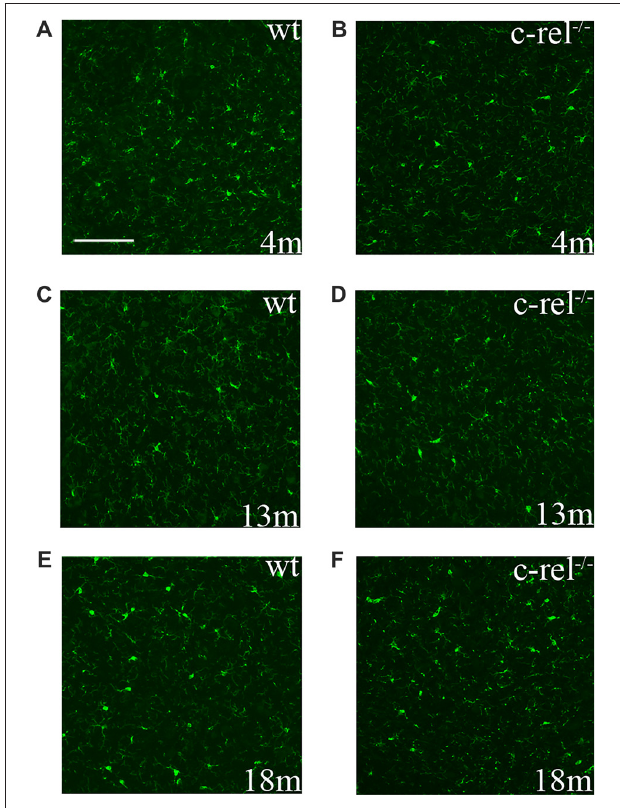
FIGURE 2 | Ionized calcium binding adapter molecule 1 (Iba1) immunoreactivity in c-rel − / − and wt mice. Pictures of SN sections from 4- (A,B) , 13- (C,D) and 18-month-old animals (E,F) illustrating Iba1 immunostaining. No evident changes in microglial activation were found in c-rel − / − mice (B,D,F) compared to age-matched wt (A,C,E) . Immunofluorescence images are representative of five sections from each animal ( n = 3 animals per group). Abbreviations: SN, substantia nigra. Scale bar: in (A) = 100 µ m for (A–F)